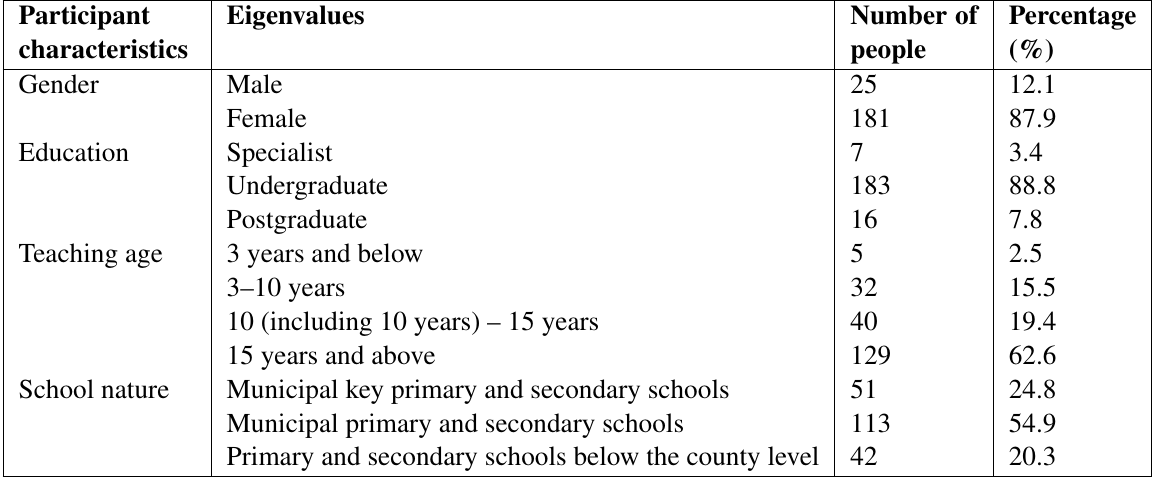
Table 2 Test index coefficients of model